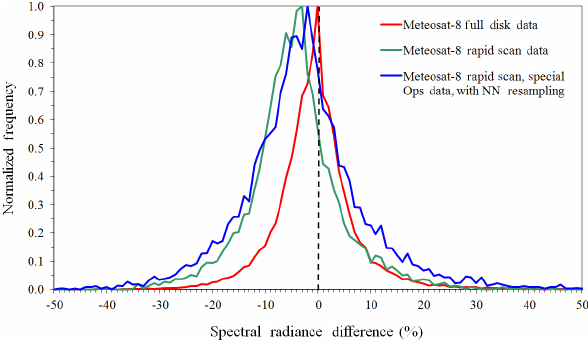
Figure 13. Comparison of SEVIRI IR3.9 band spectral radiance differences recorded at active fire pixels observed simultaneously by Meteosat-9 operated in standard mode full disk viewing and Meteosat-8 operated in both standard mode and a number of spe- cial operation modes. The red line shows the difference between Meteosat-8 and Meteosat-9 signals when the former is operated in normal mode, with no time difference between observations; the green line shows when Meteosat-8 rapid scan mode was used, which resulted in time differences of 50–65s between matched ob- servations of the two satellites; the blue line shows when Meteosat- 8 rapid scan data were processed without the FIR filter and with a nearest neighbour geometric resampling scheme (rather than the normal bi-cubic function). From these intercomparisons, estimates of the radiometric uncertainties introduced by the SEVIRI level 1.0 to level 1.5 pre-processing operations were deduced for use in FRP uncertainty specification (Sect.